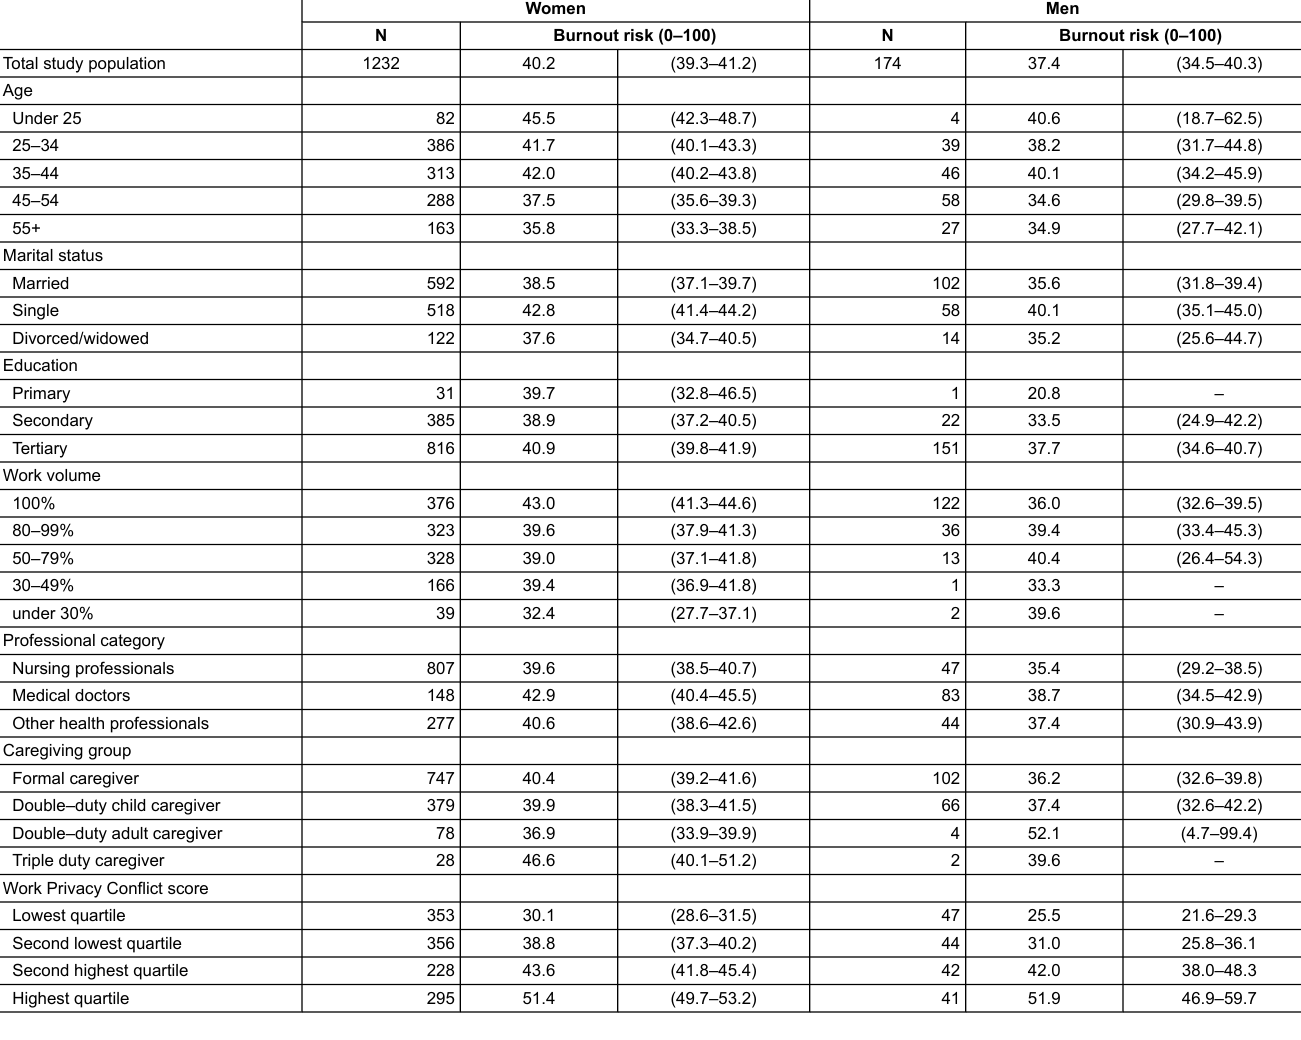
Table 1: Average burnout risk score for women and men, unadjusted.